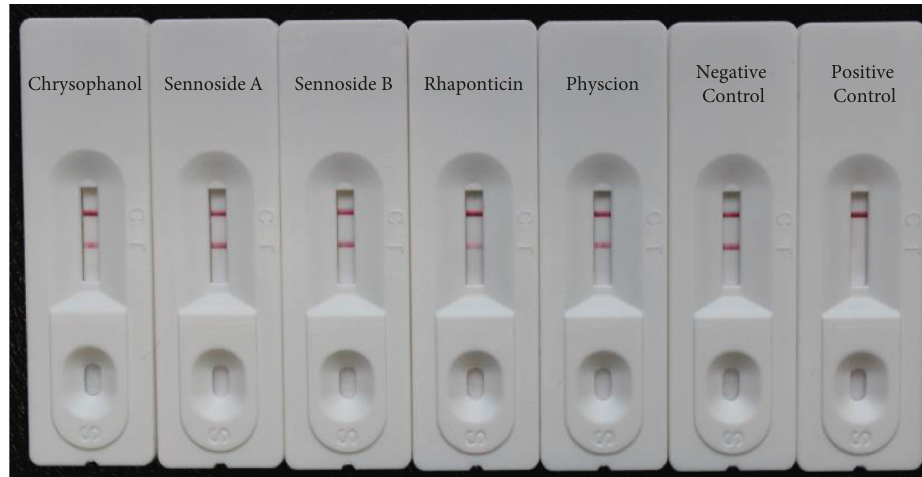
Figure 6: CGIC strip specificity tests of some analogues. Each standard solution was diluted in distilled water at a concentration of 5000ng mL − 1 . The negative control was distilled water, while the positive control was rhein at a concentration of 400ng mL − 1 . Each sample dilution was analyzed in triplicate, and the figure shows representative images.